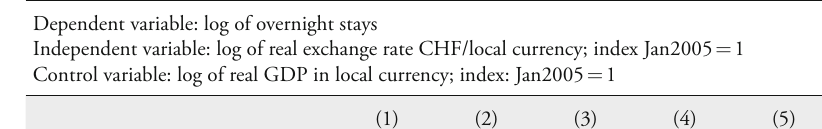
Table 6: Customer Segment of